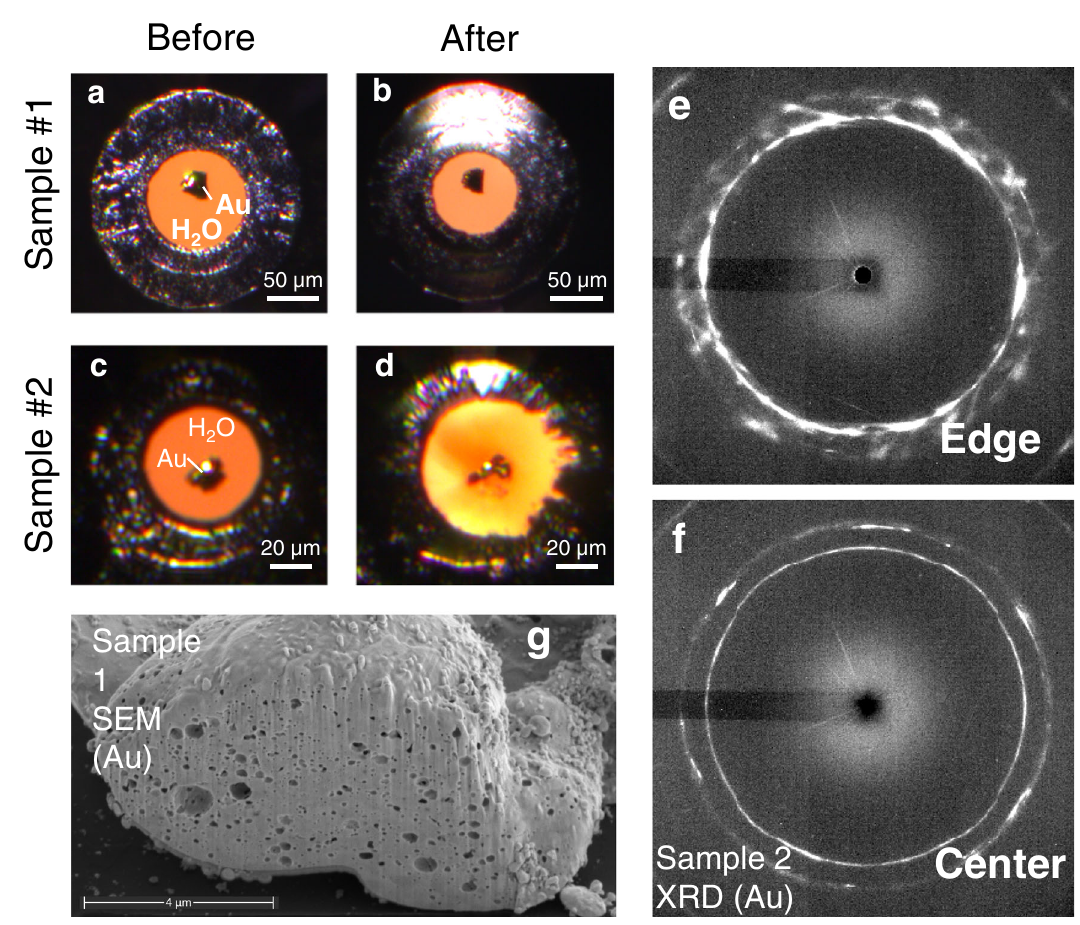
Fig. 1 Sample changes resulting from X-ray heating. a – d Photomicrographs of samples #1 and #2 before and after the PAL-XFEL experiment, viewed under transmitted and re fl ected illumination. a Sample #1 before the experiment at 1.7 GPa and b after the experiment at 52 GPa, respectively. c Sample #2 before the experiment at 2.2 GPa and d after the experiment at 62 GPa, respectively. For ( d ) the intensity of transmitted light was varied in order to enhance the color variations in the surrounding H 2 O medium. e , f Synchrotron X-ray diffraction collected after the experiment from the edge ( e ) and center ( f ) of the Au foil in sample #2. g Secondary electron images showing a cross-section through the recovered Au from sample